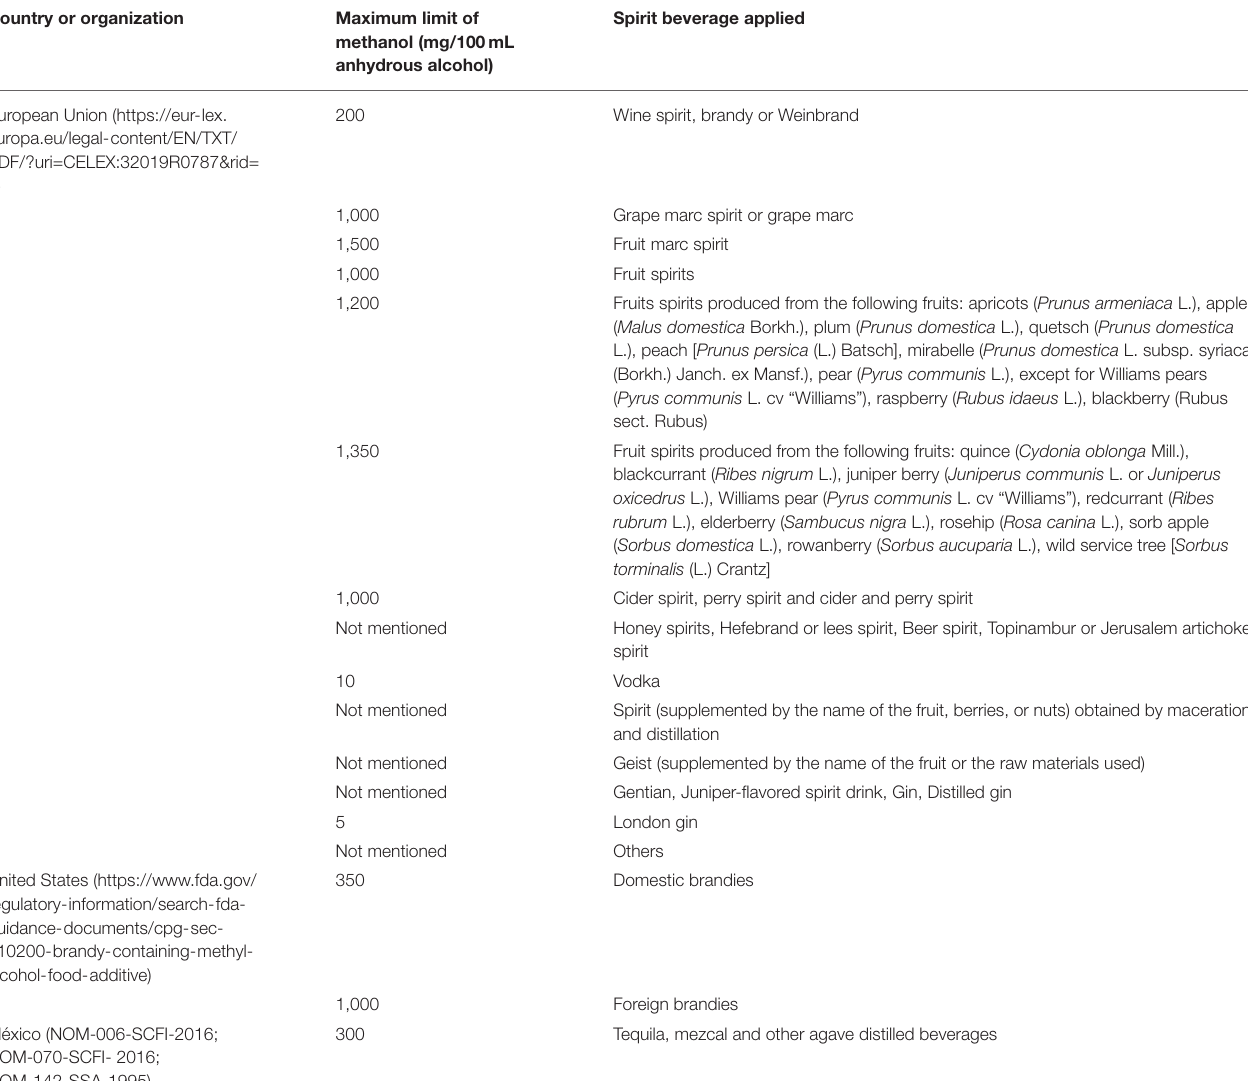
TABLE 3 | Legal limits for methanol contents (in grams per liter of 100% vol. alcohol) in different spirits. Country or